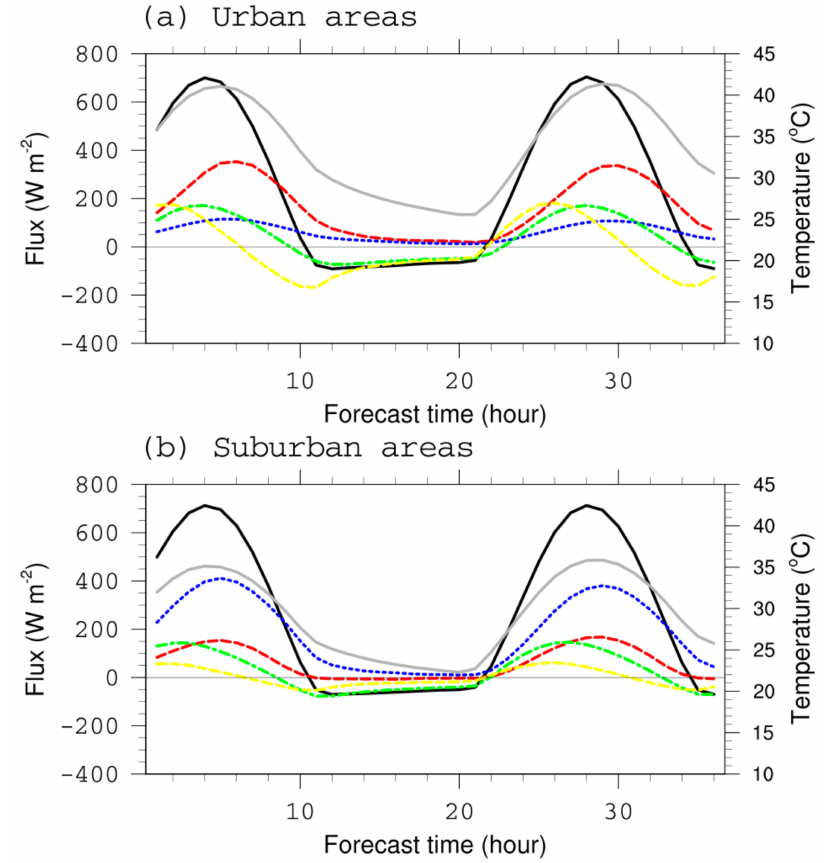
Figure 4. Time series of surface energy fluxes averaged at ( a ) urban points (urban fraction ≥ 0.3) and ( b ) suburban points (urban fraction < 0.3) in CTL from 15–21 July 2018. Net radiation flux (black), sensible heat flux (red), latent heat flux (blue), ground heat flux (green), and heat storage (yellow). Gray lines indicate the skin temperature. Units are W m − 2 and K for fluxes and temperature,